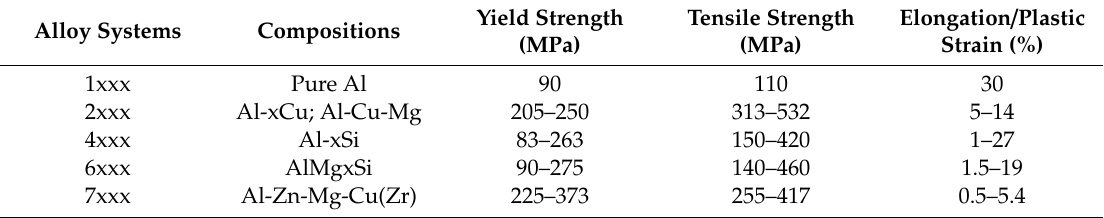
Table 1. The families of Al-based alloys fabricated by SLM processing (with or without heat treatment).